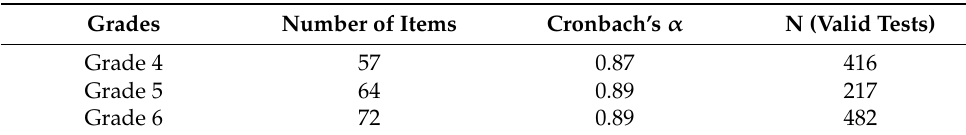
Table 10. Test reliability indicators by grade.